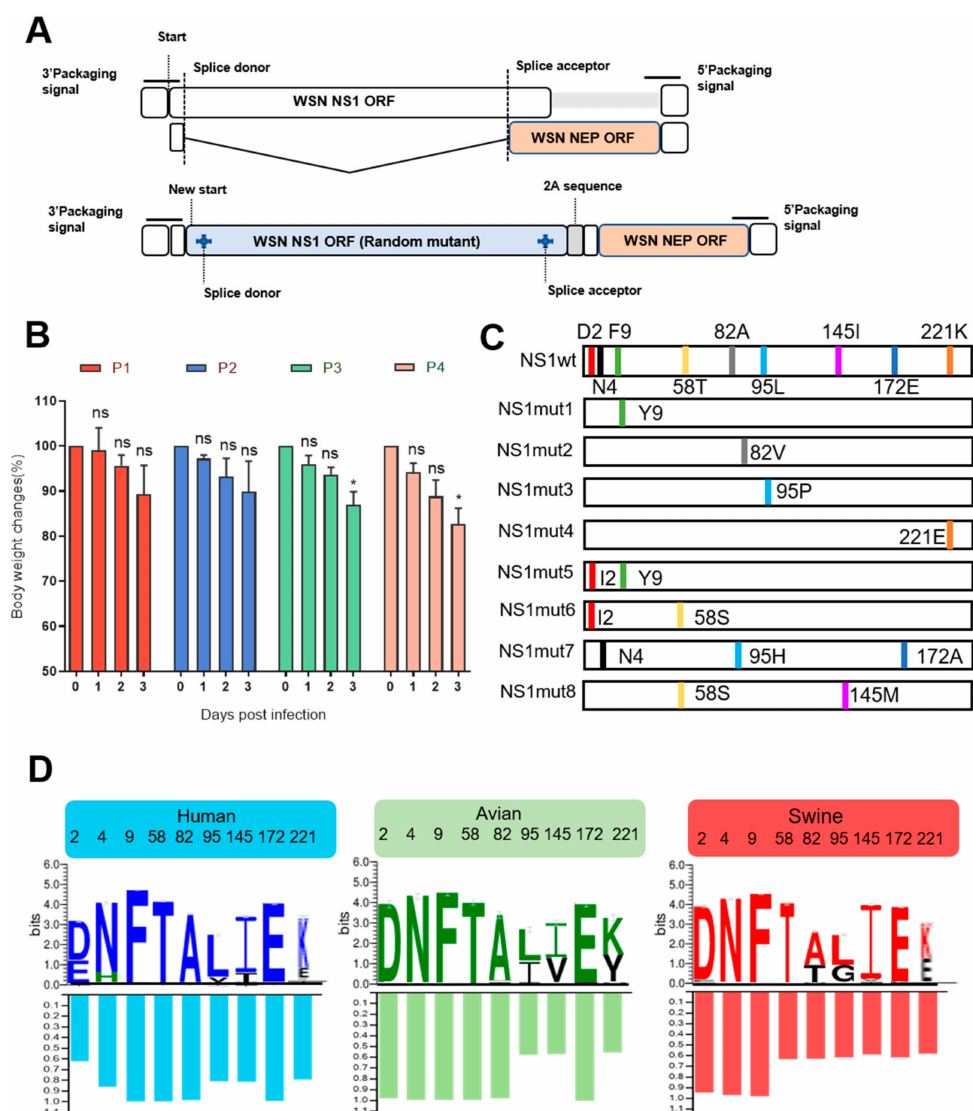
Figure 1. Generation and characterization of the NS1 mutants from the lung-to-lung passaged virus library. ( A ) Schematic representation of the wild type NS segment and the NS1-2A-NEP linear segment. The splice donor (SD) and acceptor site (SA) of the linear NS segment were mutated to prevent gene splicing. NS1 and NEP are co-translationally separated by the recoding activity of the 2A peptide of porcine teschovirus 1 (PTV-1). ( B ) Lung-to-lung passage of library virus in mice. Six to eight-week-old BALB/c mice were infected intranasally with the NS1 random mutant library viruses. The lungs were collected and homogenized on 3 dpi. The resulting supernatants were used for the next round infection. The illustrations show the mice body weight changes in each passage. p values were calculated by using the Student’s t -test, ns = not significant, * p < 0.05 ( C ) The identified NS1 mutations from purified lung-to-lung passage samples. ( D ) Prevalence and proportion of amino acids at selected NS1 mutation residues in different hosts of H1N1 IAVs. The logo plot represents the prevalent amino acid at each NS1 mutant site from human, avian and swine H1N1 influenza virus. The histogram shows the predominant amino acids frequency at every selected